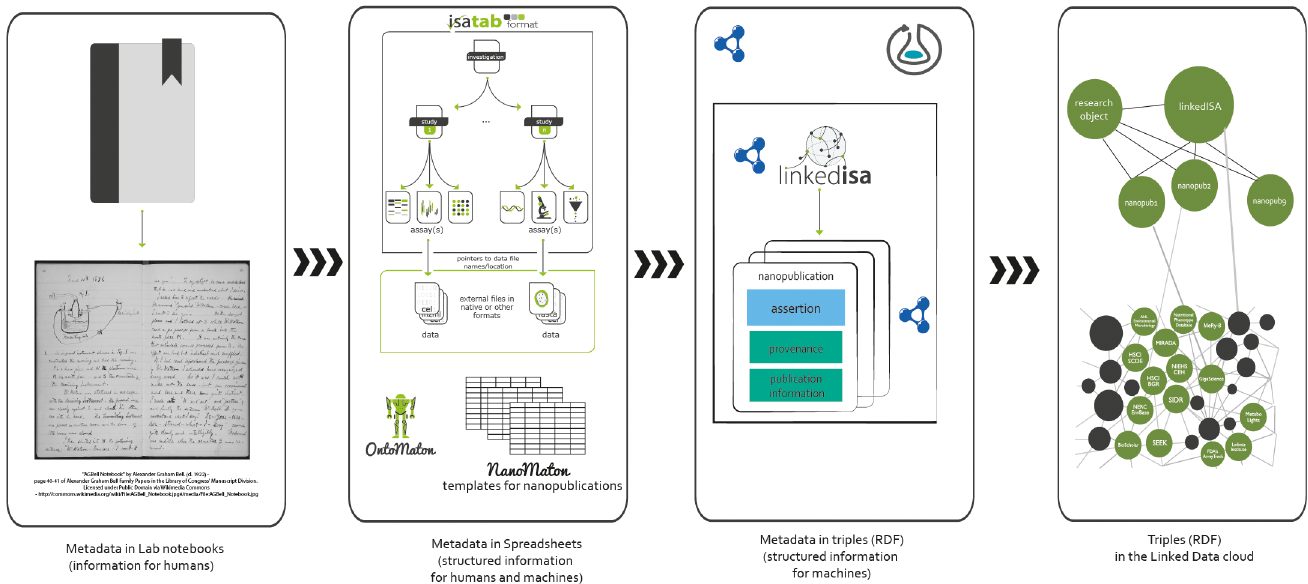
Fig 1. A graphical representation showing the role of ISA, Nanopublication and Research model in progressively structuring experimental information, moving from hand written notes in laboratory books to semi-structure tab-delimited files and fully explicit linked data.